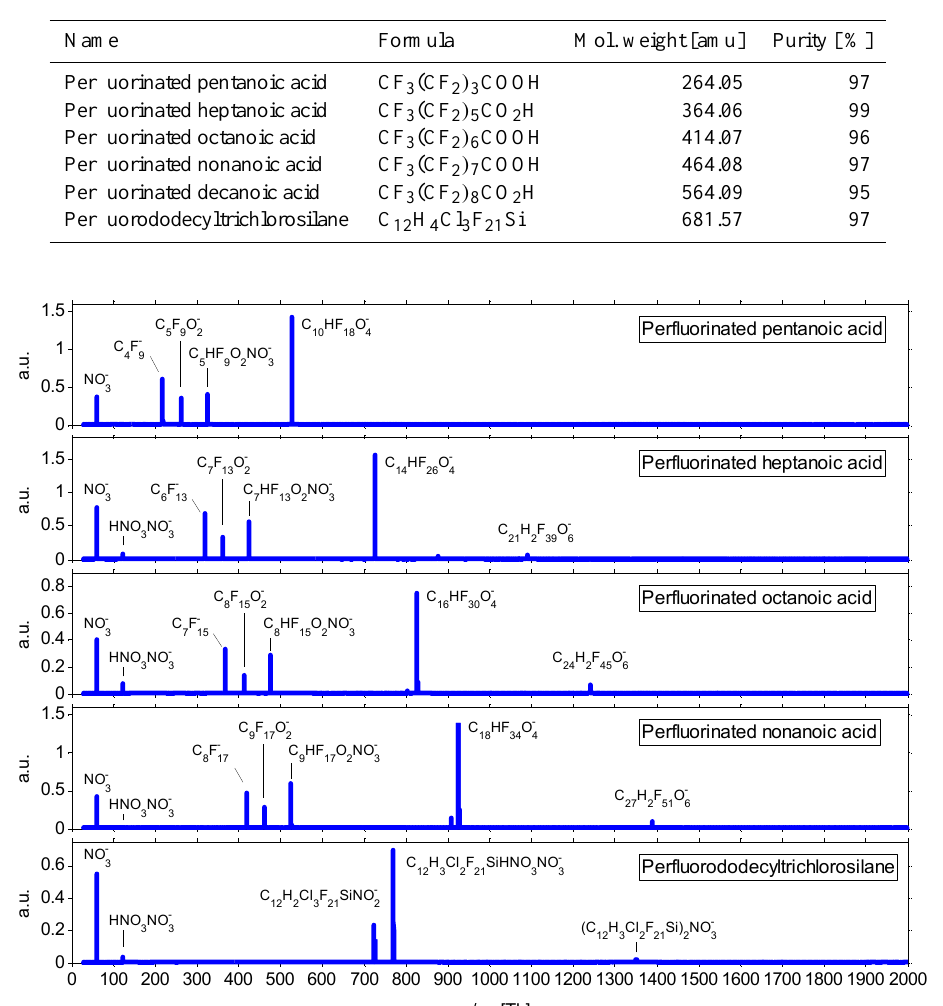
Figure 3. Spectra for all compounds used for depletion mode experiments. Primary ions are NO − three monomer peaks for the perfluorinated acids originate from proton transfer to NO − fragmentation (loss of the acid group, left peak). Dimers and trimers of the perfluorinated acids are present only as one main peak. Notice the stepwise addition of CF 2 building blocks for the perfluorinated